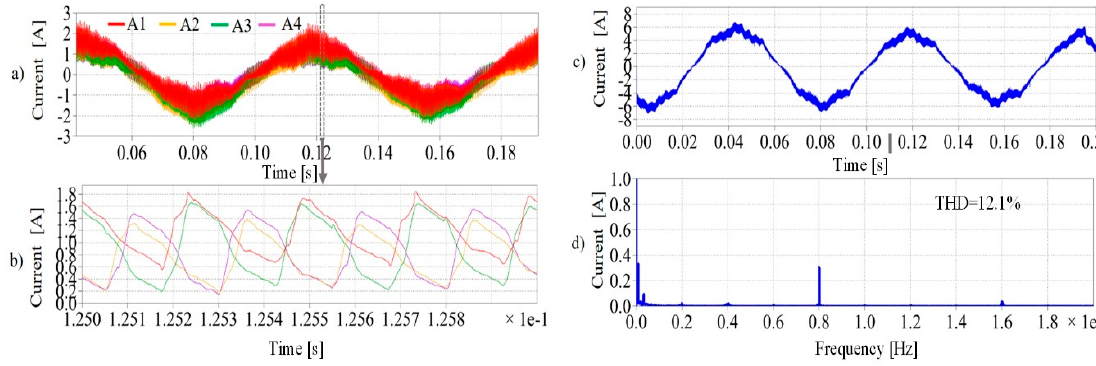
Figure 6. ( a , b ) Experimental result of phase currents with phase-shift CPWM. ( a ) Two fundamental period range. ( b ) The cursor range of Figure 6a. ( c , d ) Equivalent phase current with phase-shift CPWM. ( c ) Time-domain current waveform. ( d ) FFT spectrum of Figure 6c.